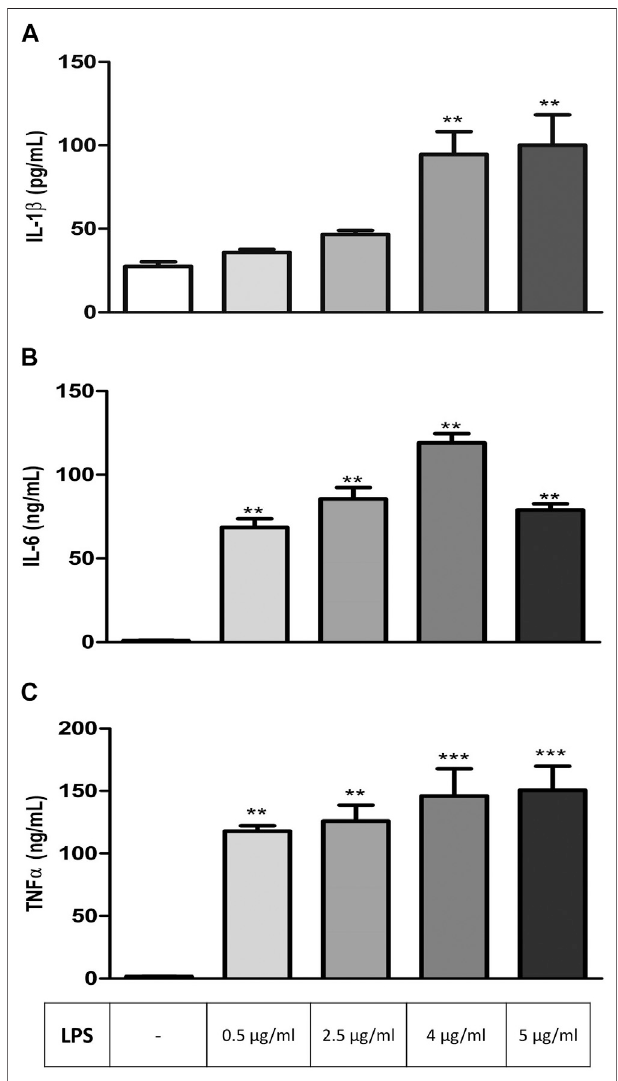
FIGURE 1 | LPS-induced increase in in fl ammation markers in RAW264.7 cells. Shown are IL-1 β (A) ; IL-6 (B) , TNF α (C) levels in response to increasing LPS concentrations. Data are expressed as mean ± S.E.M. (** p < 0.01; *** p < 0.001 vs. the control group, n (cid:1) 5 – 7, One-way ANOVA with post hoc Tukey – Kramer multiple comparisons test or Student ’ s t